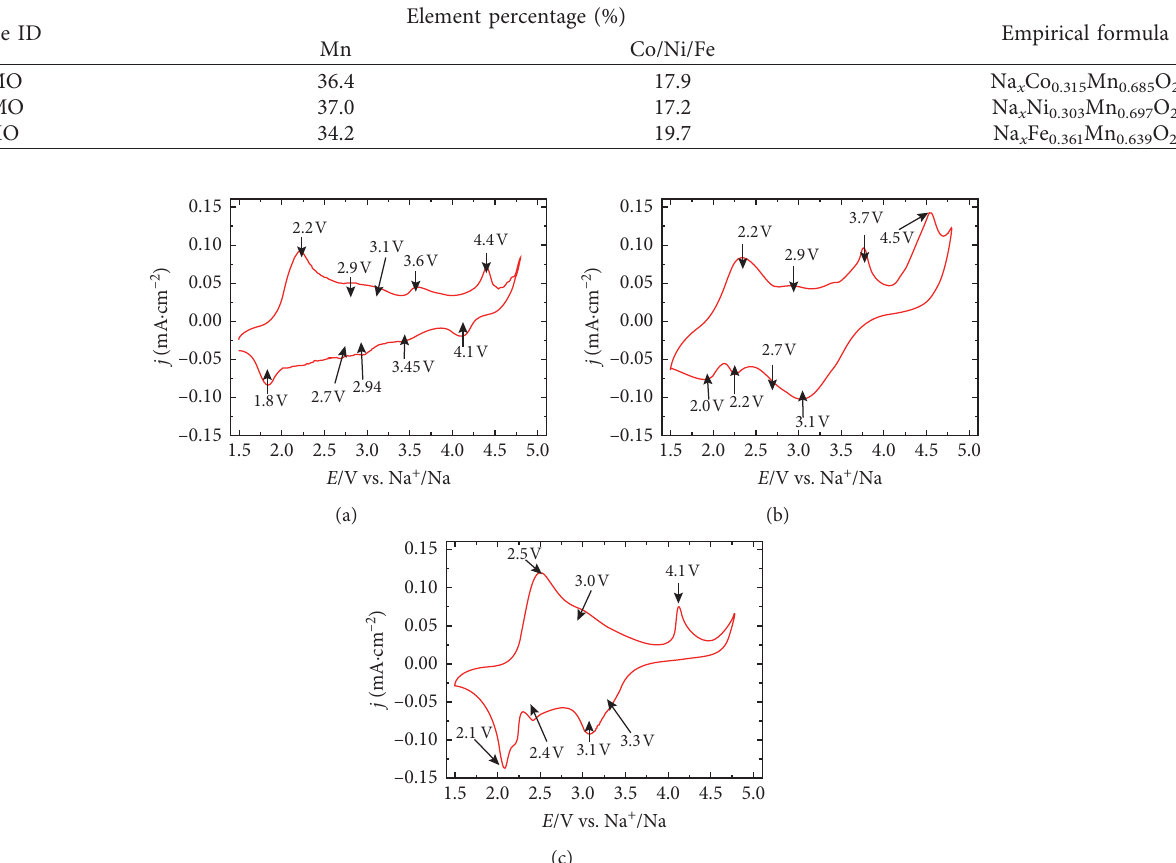
Table 2: Chemical compositions of the samples determined by AAS.